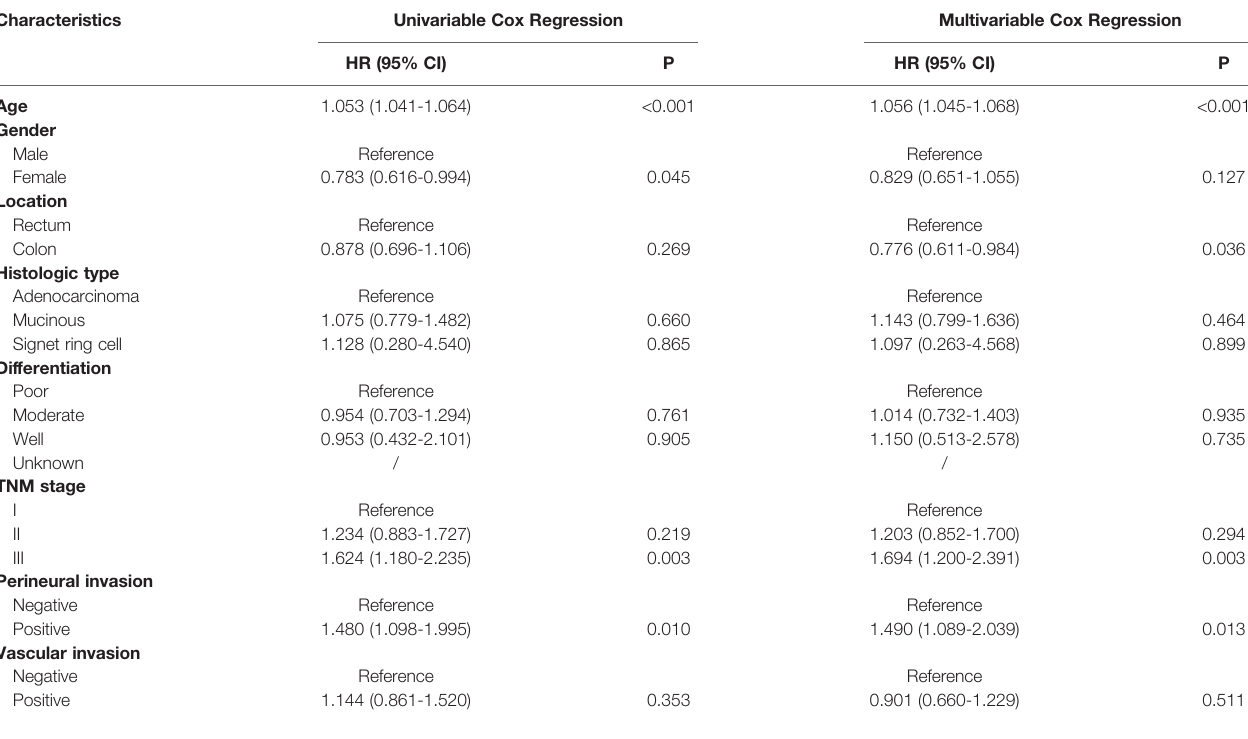
TABLE 5 | Univariable and multivariable Cox regression of overall survival in patients who survived over 5 years after surgery.